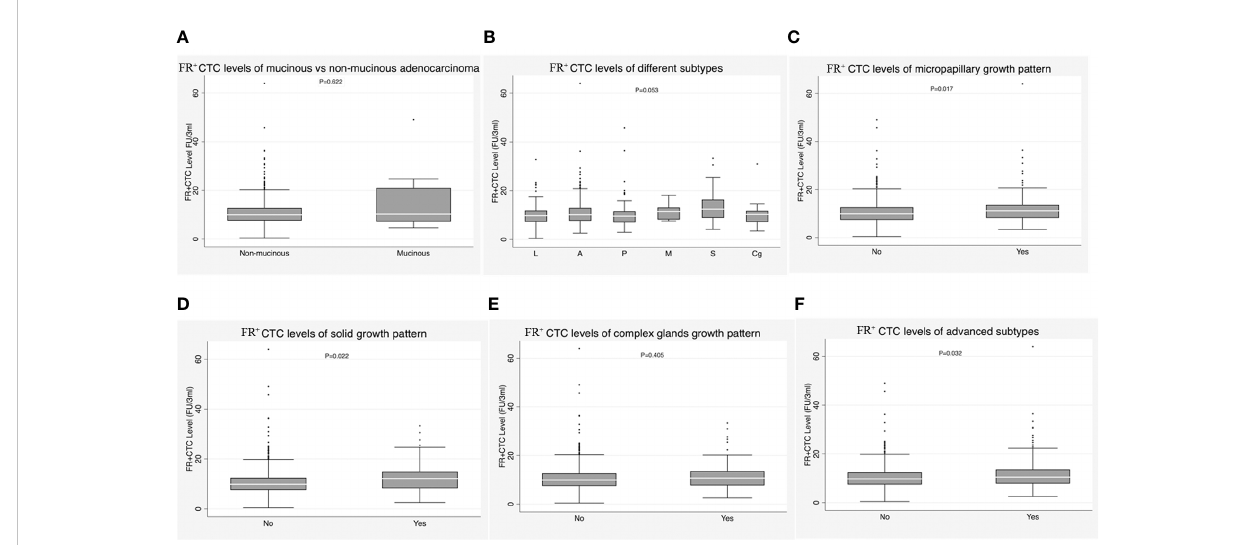
FIGURE 3 (A) Correlation of FR + CTC level with mucinous adenocarcinoma vs. non-mucinous adenocarcinoma in the invasive adenocarcinoma (IAC) group. (B) Correlation of FR + CTC level with lepidic subtype, acinar subtype, papillary subtype, micropapillary subtypes, solid subtype, and complex glands in the IAC group. (C) Correlation of FR + CTC level with presence vs. absence of micropapillary components in the IAC group. (D) Correlation of FR + CTC level with presence vs. absence of solid components in the IAC group. (E) Correlation of FR + CTC level with presence vs. absence of complex glands in the IAC group. (F) Correlation of FR + CTC level with presence vs. absence of advanced subtypes in the IAC group.